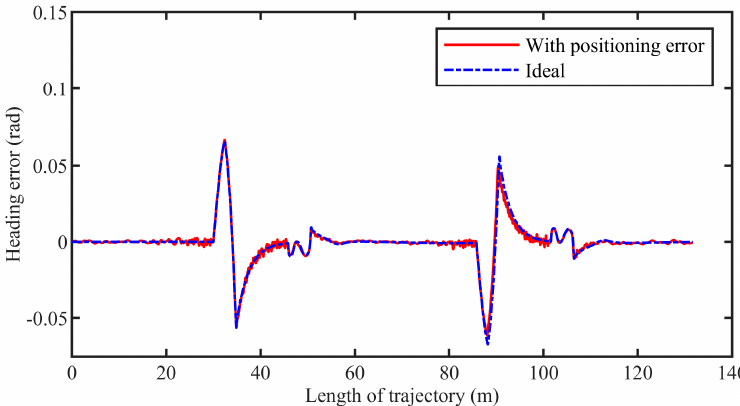
Appl. Sci. 2019 , x , x FOR PEER REVIEW Figure 22. Displacement error of the simulation with positioning errors. Figure 22. Displacement error of the simulation with positioning errors. Figure 22. Displacement error of the simulation with positioning errors.